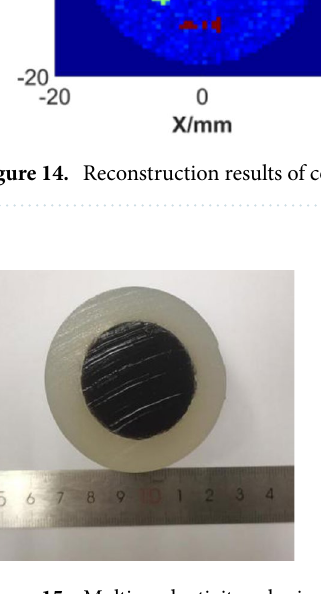
Figure 15. Multiconductivity gel mimics.